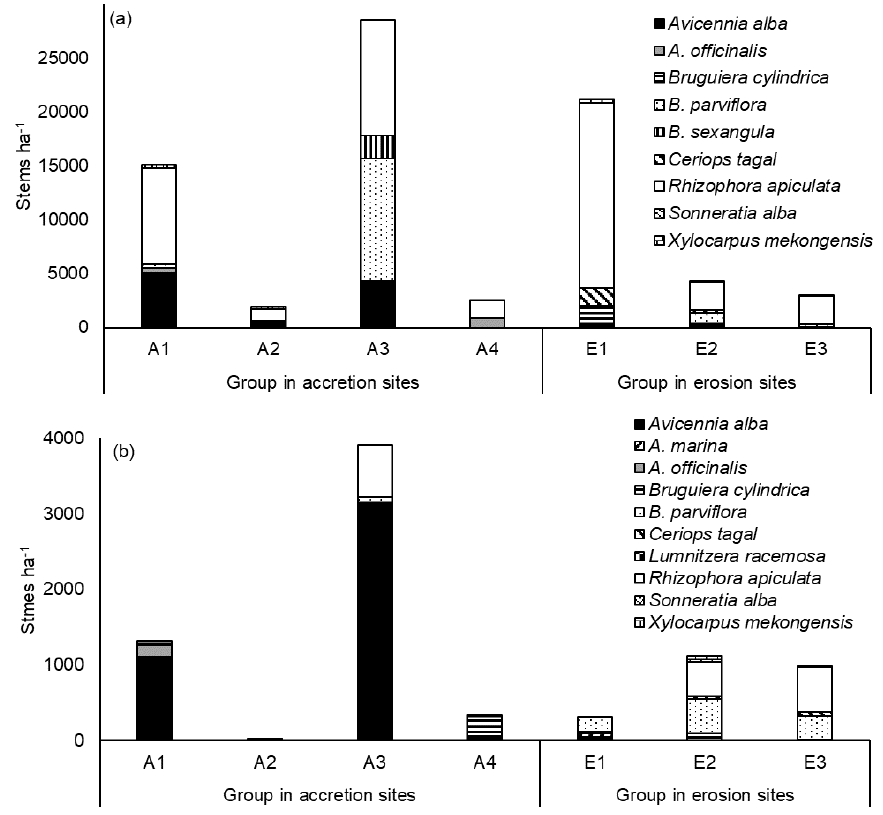
Figure 6. Density of ( a ) sapling (DBH < 6 cm and height ≥ 50 cm) and ( b ) seedling (height < 50 cm) by species in groups A1, A2, A3, and A4 in accretion sites and groups E1, E2, and E3 in erosion sites. Plots belonging to each group are shown in Figure 2.